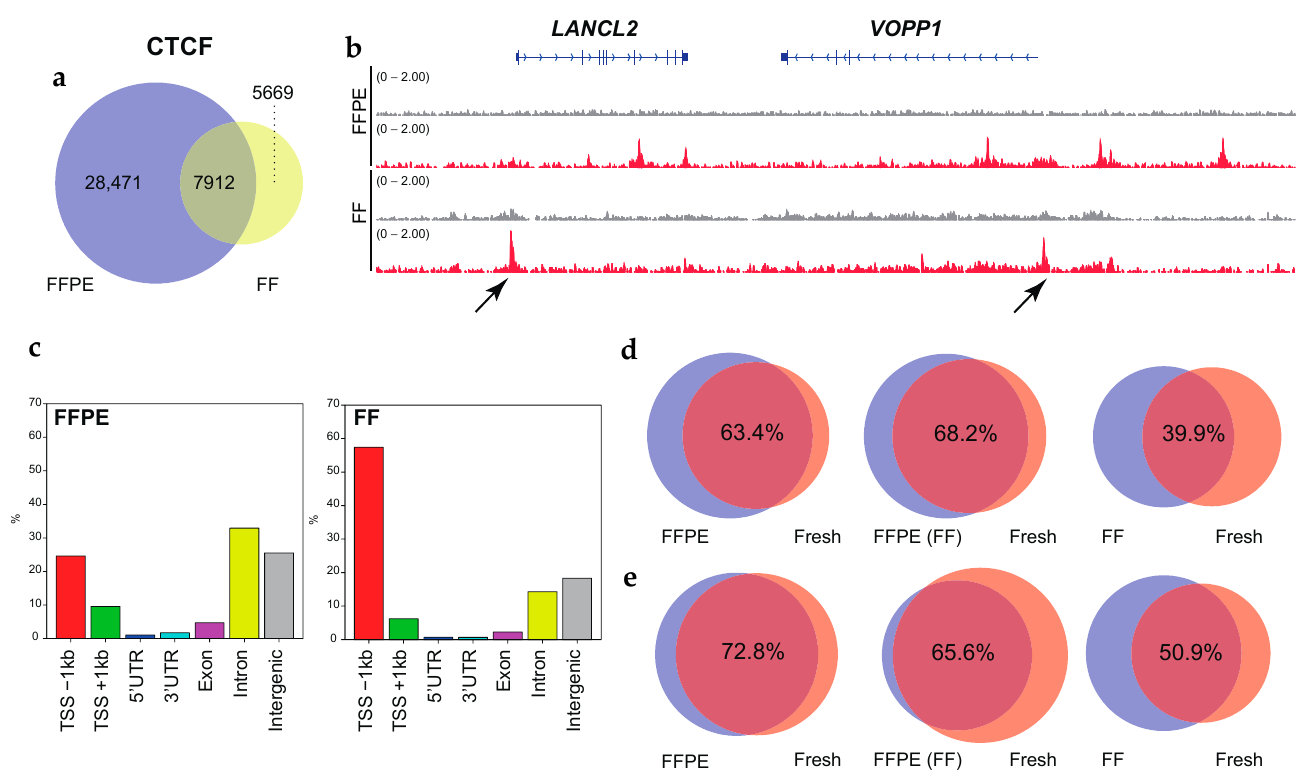
Figure 3. The FFPE samples retain accurate CTCF binding. ( a ) Venn diagrams showing the overlap of CTCF binding between FFPE and the matched FF in OCCC. ( b ) IGV tracks of CTCF peaks (red), comparing FFPE and the matched FF in OCCC. Input controls are shown as gray. Non-concordant peaks are shown by the arrows. ( c ) Bar graphs display the genomic distribution of the CTCF binding sites in FPPE (left side) and the matched FF (right side) tissues. ( d ) Venn diagrams showing the overlap of CTCF binding between FFPE and fresh (left), pre-frozen FFPE and fresh (middle), and FF and fresh (right) in endometrial endometrioid adenocarcinoma (EEA). ( e ) Same as ( d ) but for cervical carcinosarcoma (CC). The p -value cutoff for the MACS peak calling in panels d and e is 1 × 10 ‒ 9 . The overlap ratios (%) are shown.